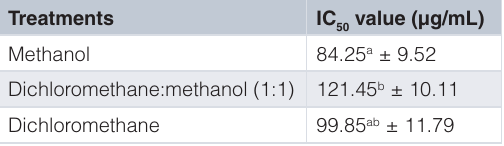
Table 1. IC values of Ancorina sp. extracts. 50